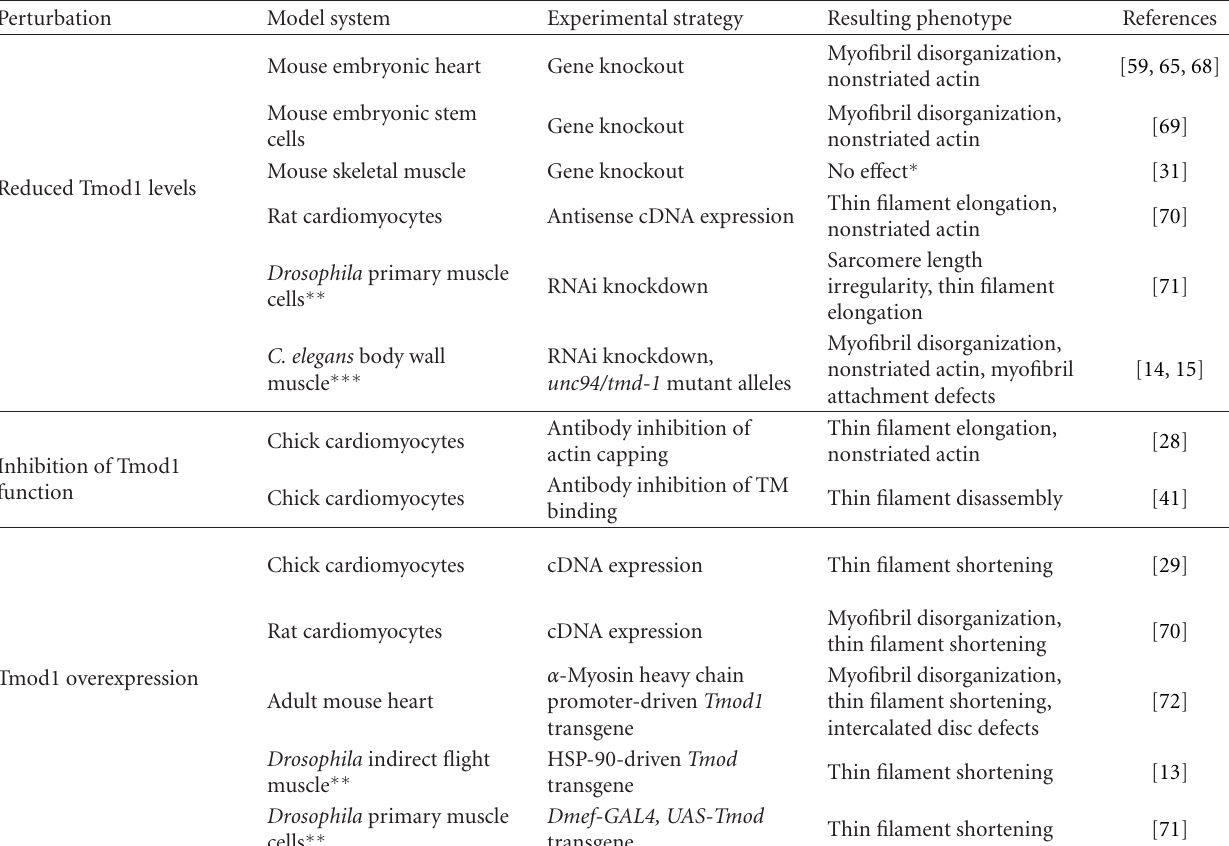
Table 2: Summary of myofibril assembly and thin filament length phenotypes in Tmod1 perturbation